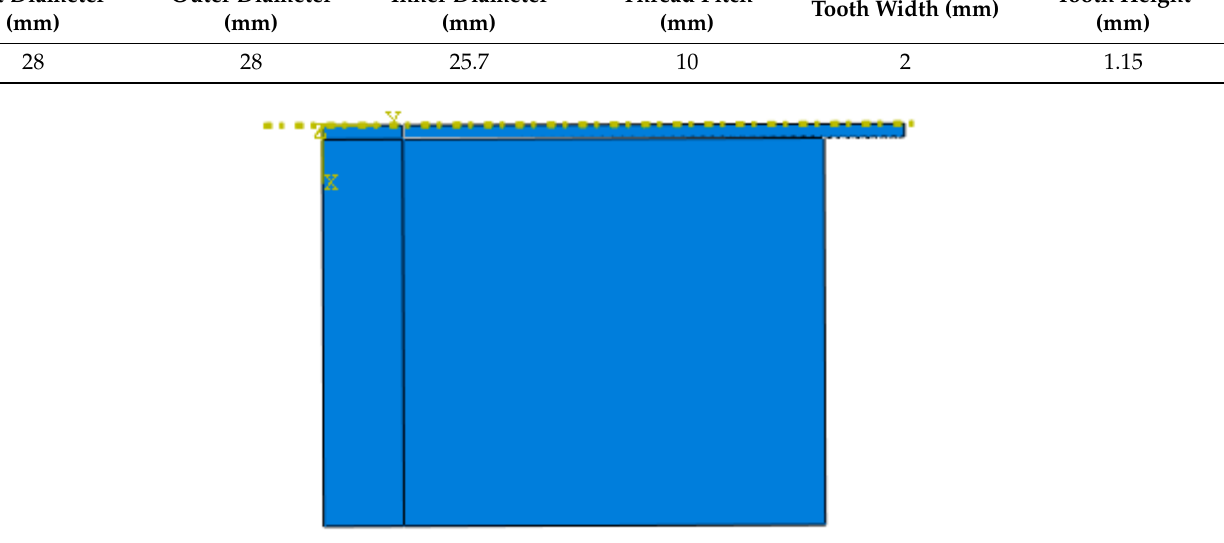
Figure 7. Axisymmetric model of GFRP anchorage concrete bottom plate.